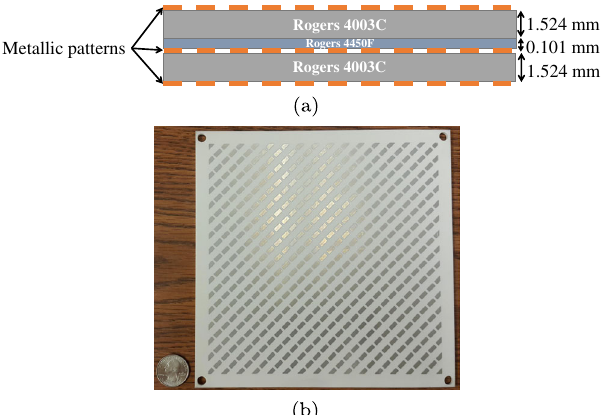
FIG. 12. (a) Photograph of the fabricated BFS. (b) Cross section of the